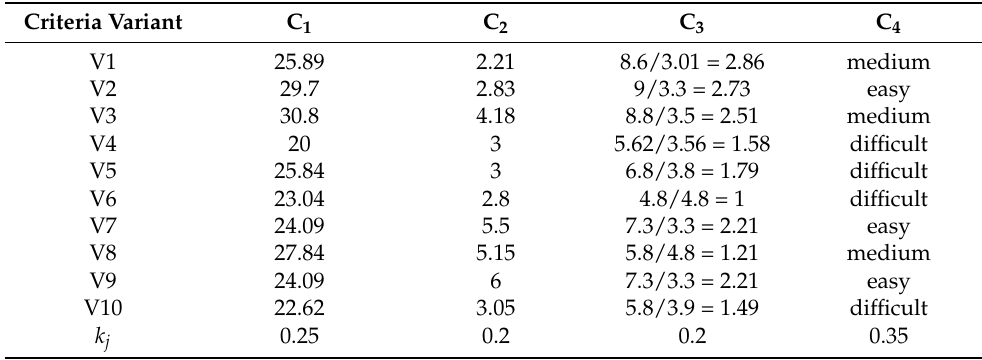
Table 7. The matrix of consequences when the training cell is configurable for the complete assembly of the electric motor by an operator.